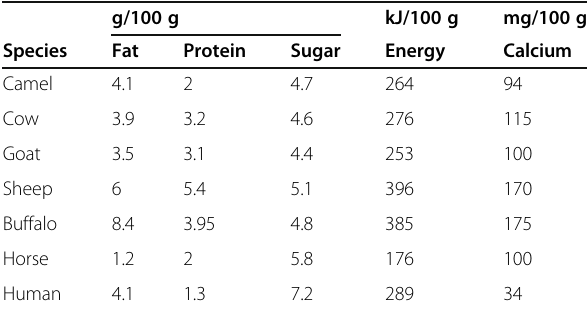
Table 1 Milk nutrient content of different species (average values) (Csapó and Salamon